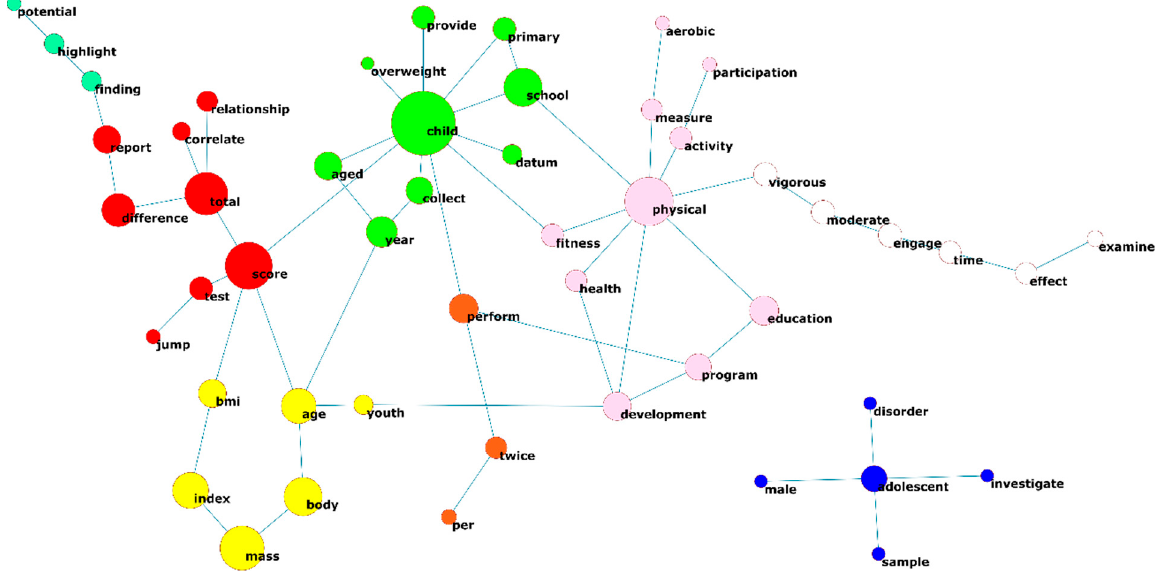
Figure 4. Network of co-occurrences between words ( ≥ 4 components). Only those nodes that obtained a minimum of 2000 co-occurrences are represented. The size of the nodes expresses the words’ weighted degree. The different colours of the nodes indicate the cluster membership calculated from a VOS algorithm.